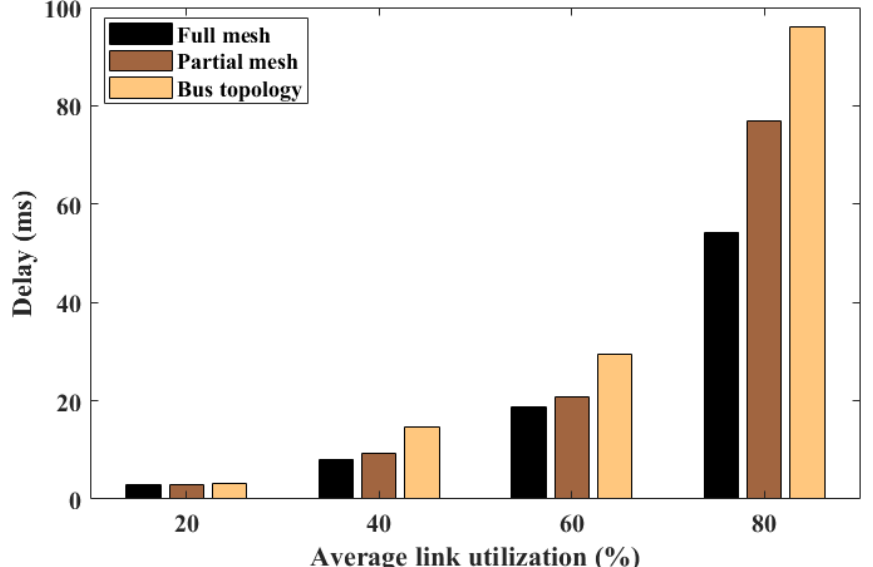
Figure 8. Time to attain optimal value for the Three Network Topologies with varying link